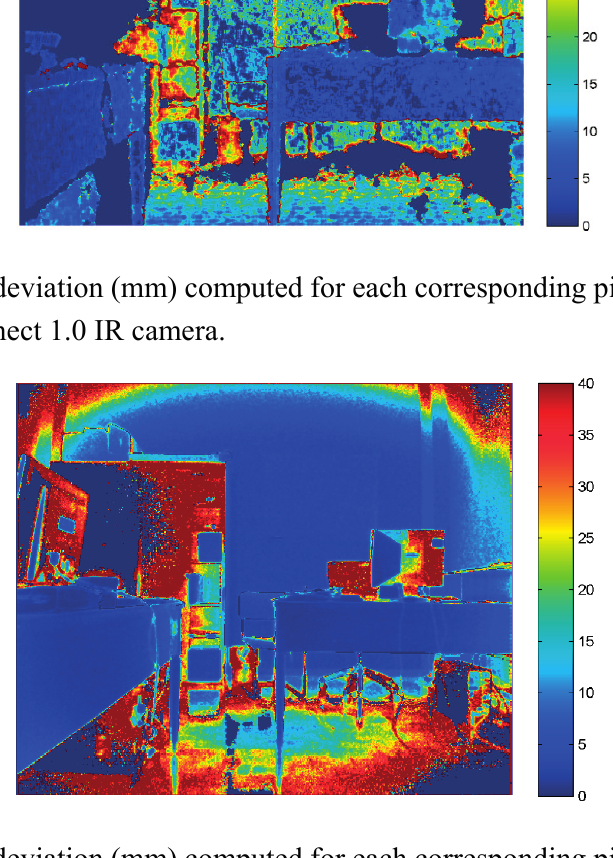
Figure 7. Standard deviation (mm) computed for each corresponding pixel of the raw depth data acquired by Kinect 2.0 IR camera.